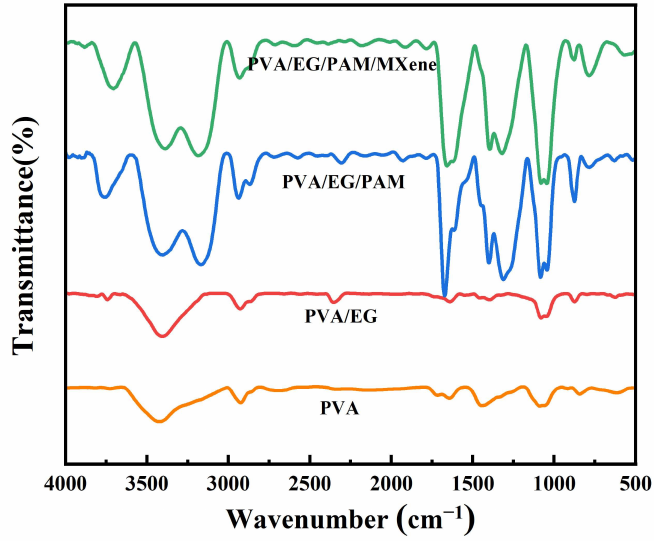
Figure 4. FTIR spectra of PVA hydrogel, PVA/EG hydrogel, PVA/EG/PAM hydrogel, and PVA/EG/PAM/MXene